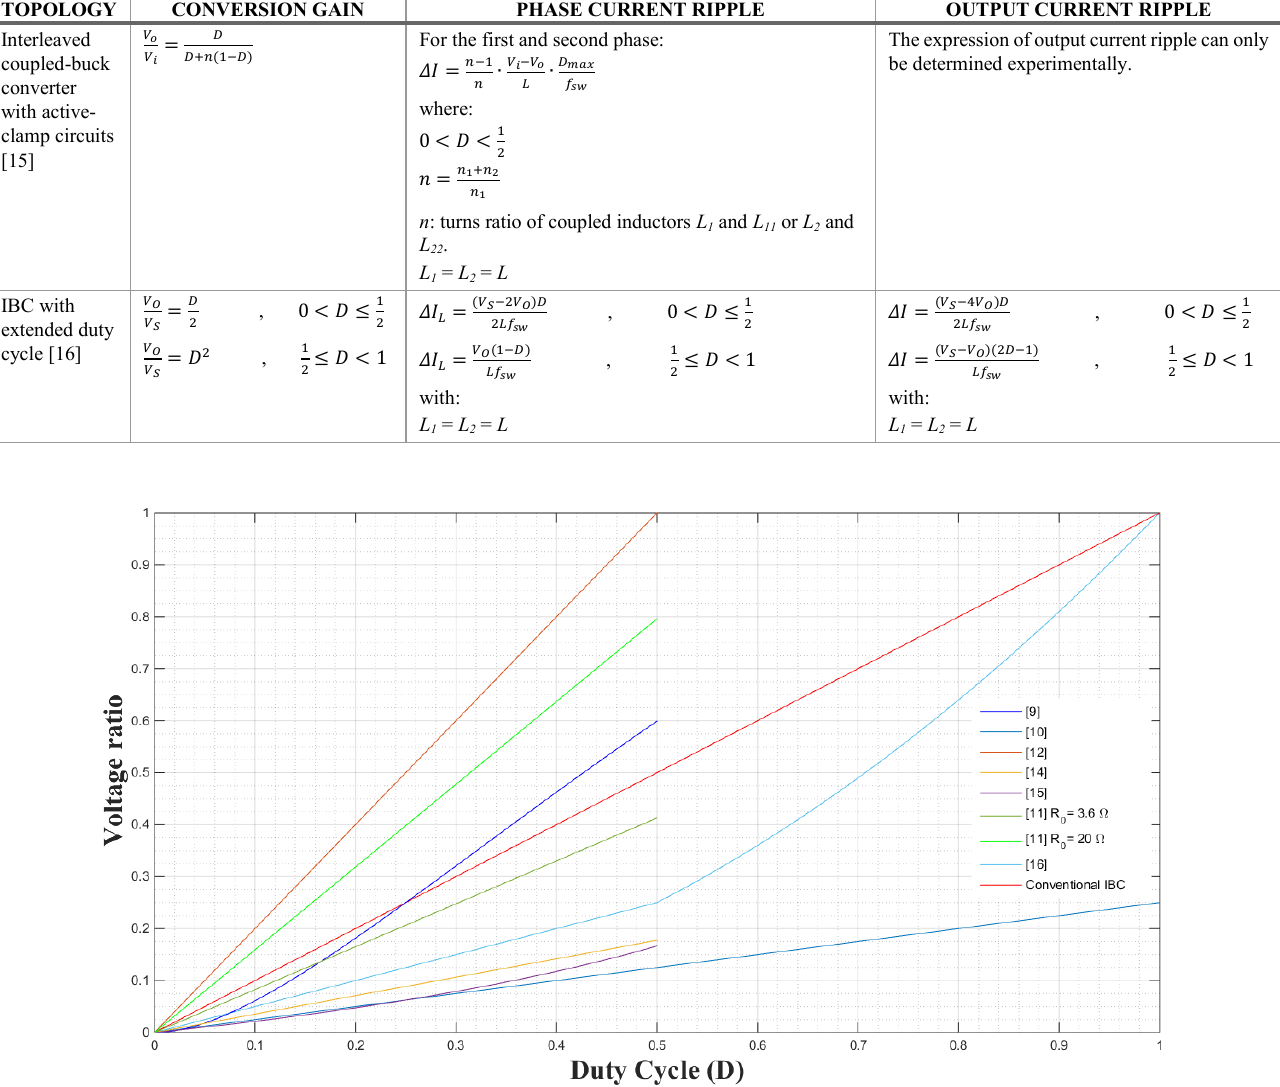
Fig. 13. Comparison of the voltage ratio according to the duty